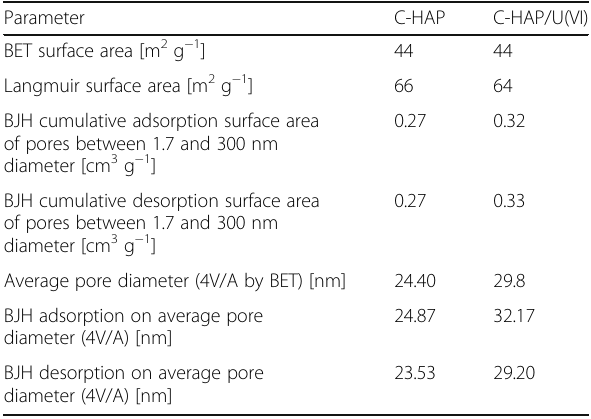
Table 3 Chosen structural parameters for C-HAP and